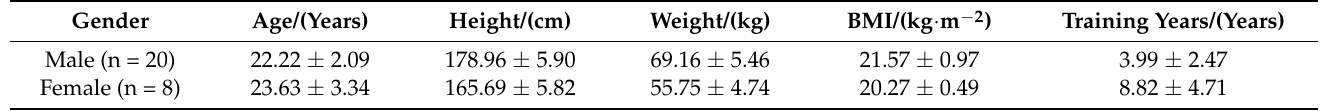
Table 1. Basic information about the athletes of the national cross-country ski training